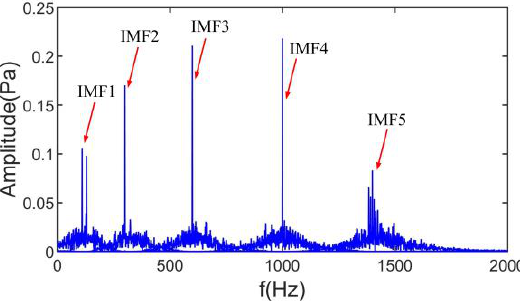
Figure 5. ASSME method separation results.